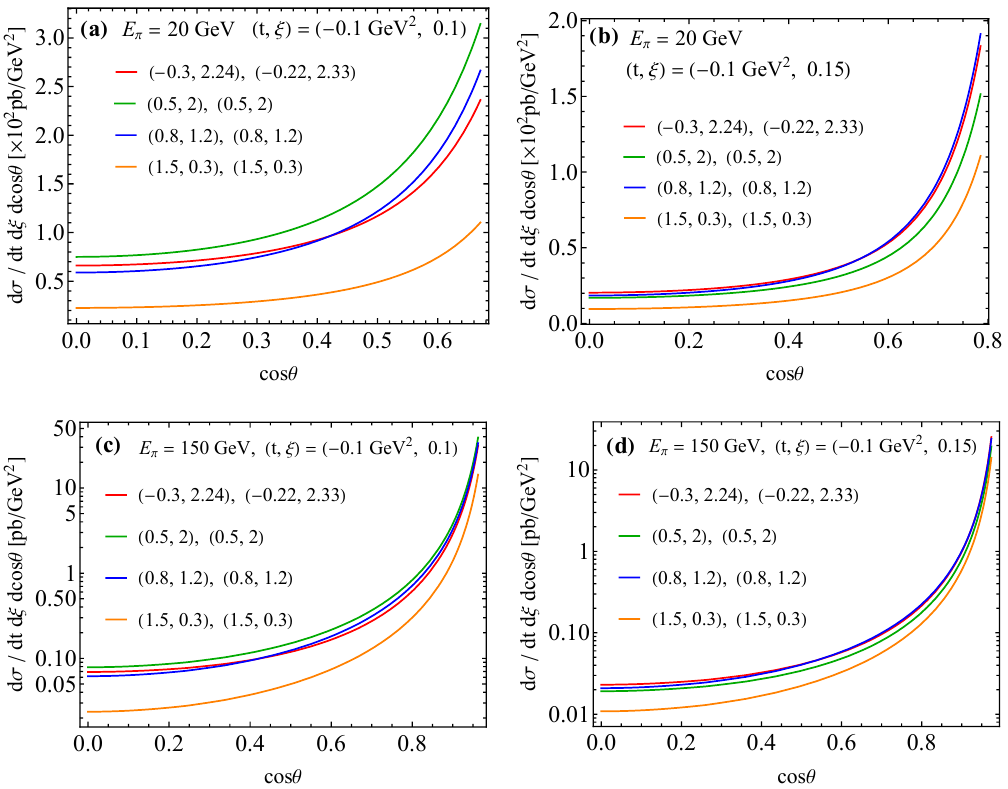
Figure 24. Differential cross section in eq. (3.34) as a function of cos θ of the observed photon with all parameters chosen to be the same as that in figure